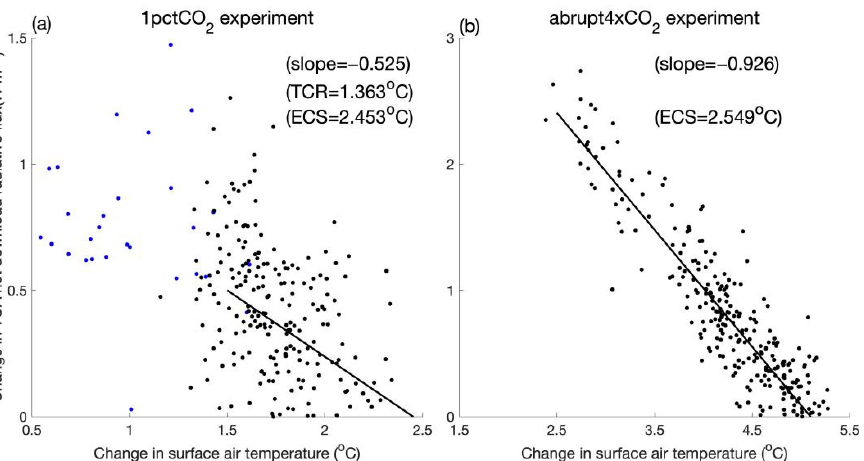
Figure 2. Results from the 1% per year CO 2 increase experiment ( a ) and the abrupt quadrupling of CO 2 experiment ( b ). The relationships between the change in net radiative flux at the TOA and the global mean surface air temperature in FOAM. The black points show the yearly data after the equilibrium warming, and the blue points are chosen from the periods at the time of CO 2 doubling. Lines represent ordinary least squares regression fits to the points. The slopes of the regression lines illustrate the strength of the feedbacks.